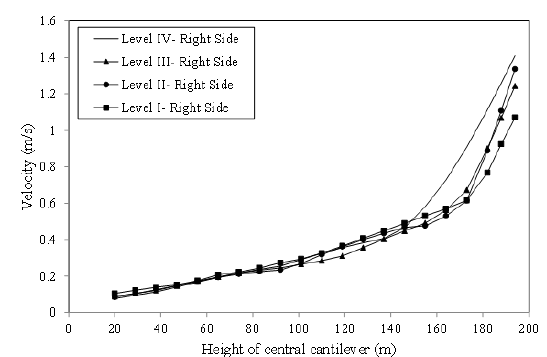
Figure 17. Non-concurrent envelope of acceleration along the height of the crown cantilever; NL-DCM